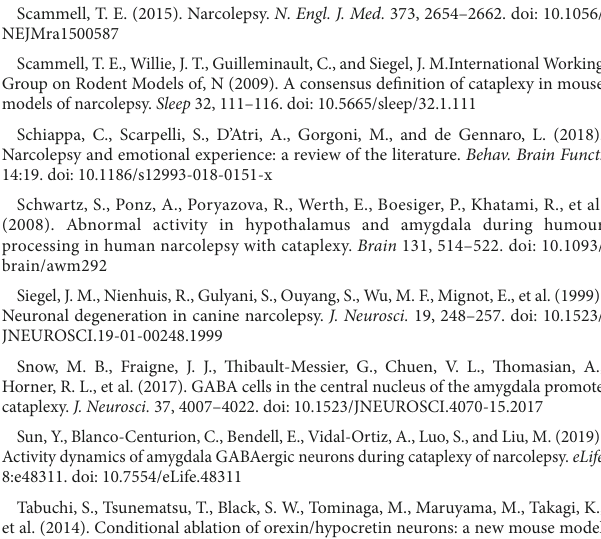
Tabuchi, S., Tsunematsu, T., Black, S. W., Tominaga, M., Maruyama, M., Takagi, K., et al. (2014). Conditional ablation of orexin/hypocretin neurons: a new mouse